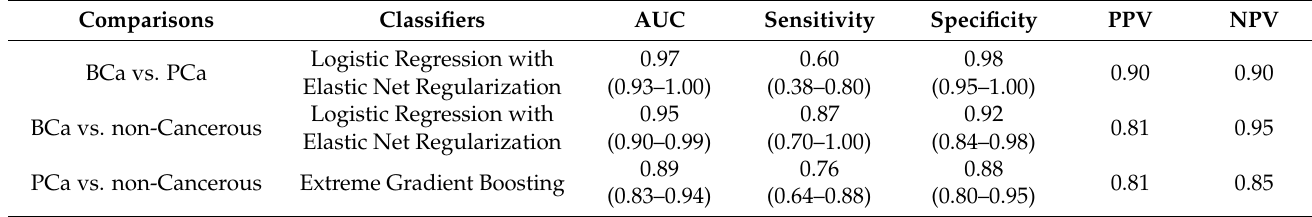
Table 2. GC-IMS diagnostic group results.